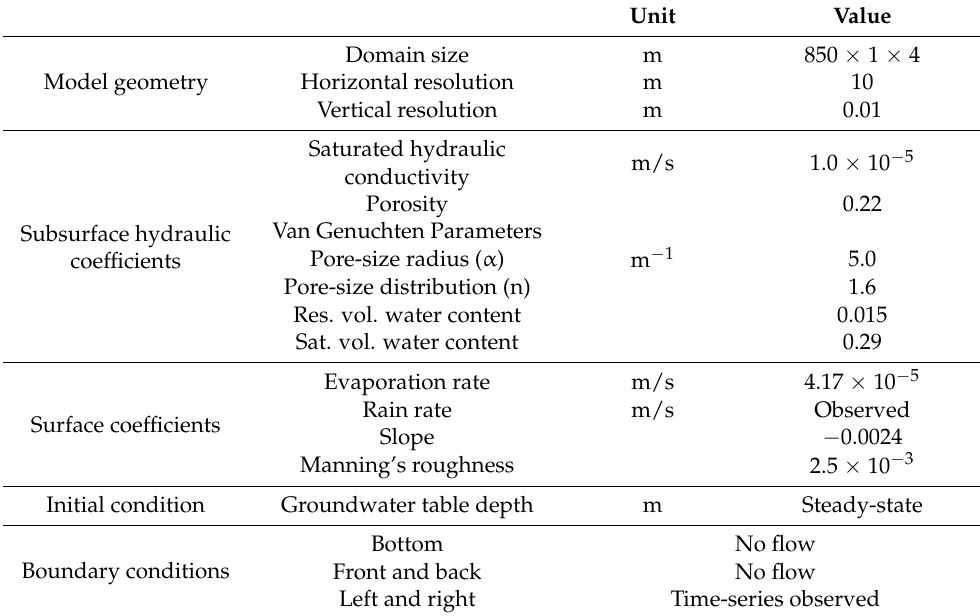
Table 4. Parameters in the BJH